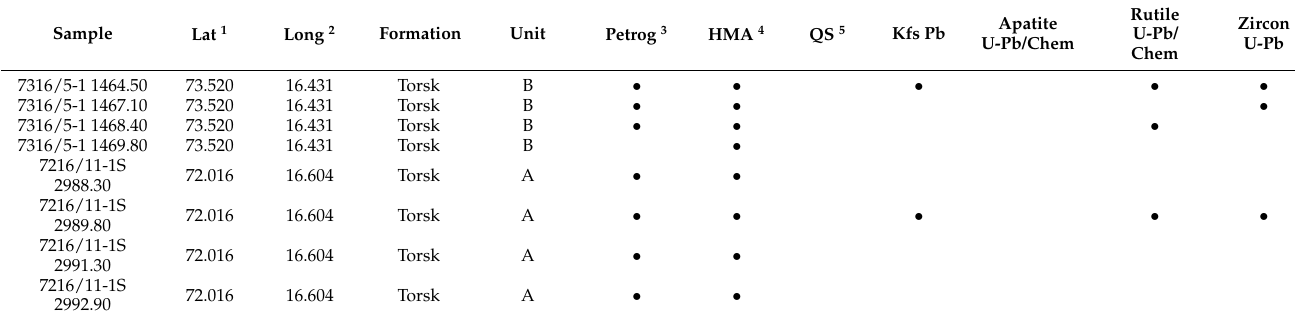
1 Latitude, 2 Longitude, 3 Petrography, 4 Heavy mineral analysis, 5 QEMSCAN. • indicates that the technique was applied to the sample.